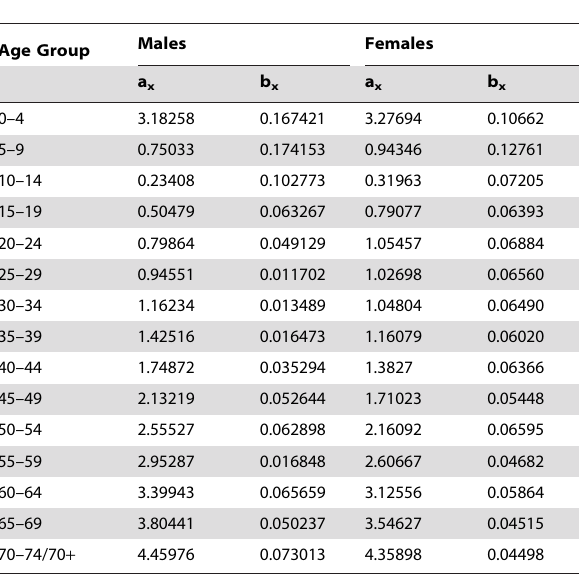
Table 1. Estimated values of a x and b x for males and females for